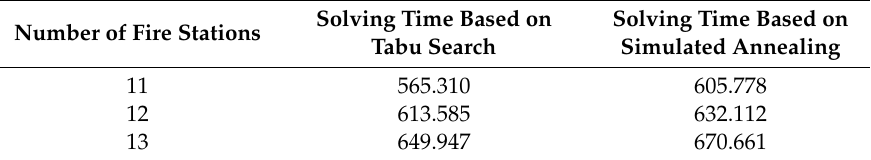
Table 20. Comparison of the average problem-solving time in seconds.